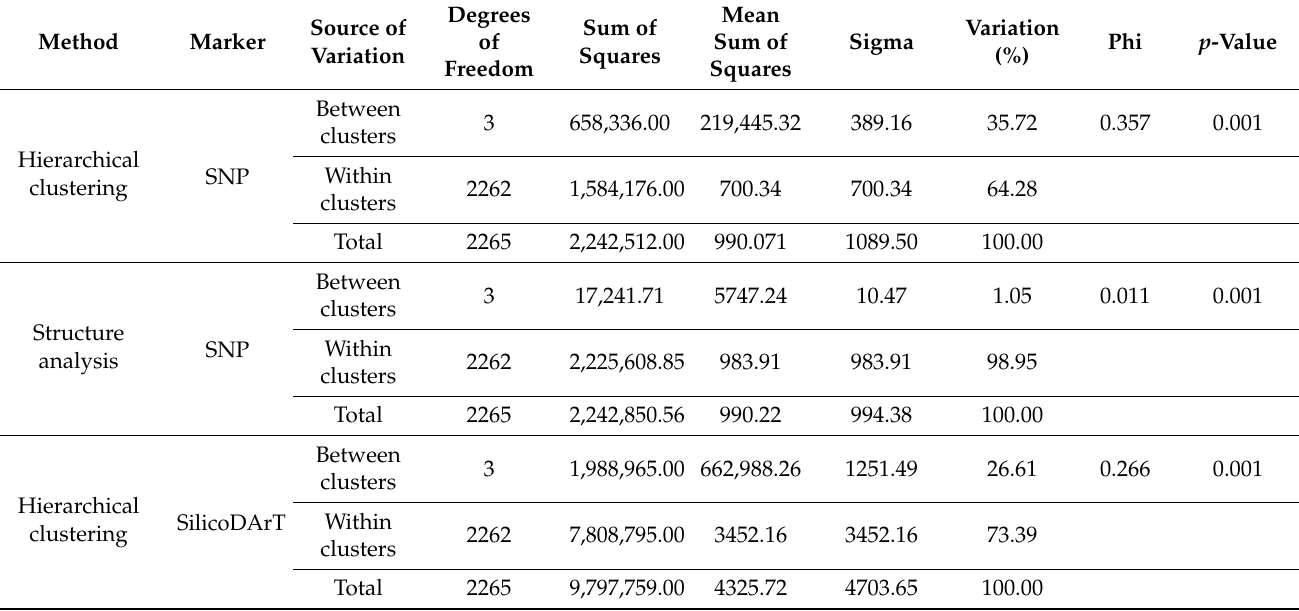
Figure 5. Cluster plots showing the four main clusters using ( a ) SNP and ( b ) SilicoDArT markers. Table 3 shows the AMOVA result for clusters and subpopulations inferred based on hierarchical clustering and structure analysis, respectively. The results show that the largest proportion (64.28% and 73.39% using SNP and SilicoDArT markers, respectively) of the total variation was contributed by the within cluster variation. The contribution of between clusters’ variation to the total genetic variation was 35.72% and 26.61% using SNP and SilicoDArT markers, respectively. Table 3. AMOVA result for clusters inferred by hierarchical